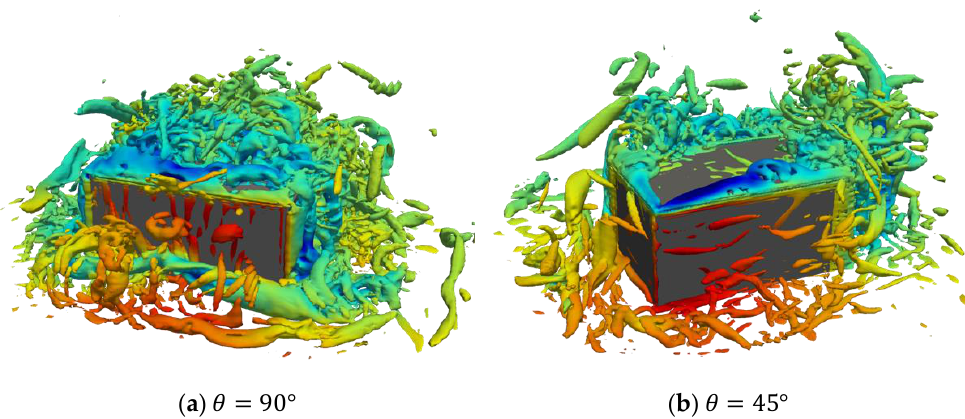
Figure 11. Topology of vorticities around the isolated building in terms of the Q-criterion. The vorticities are colored by instantaneous pressure.